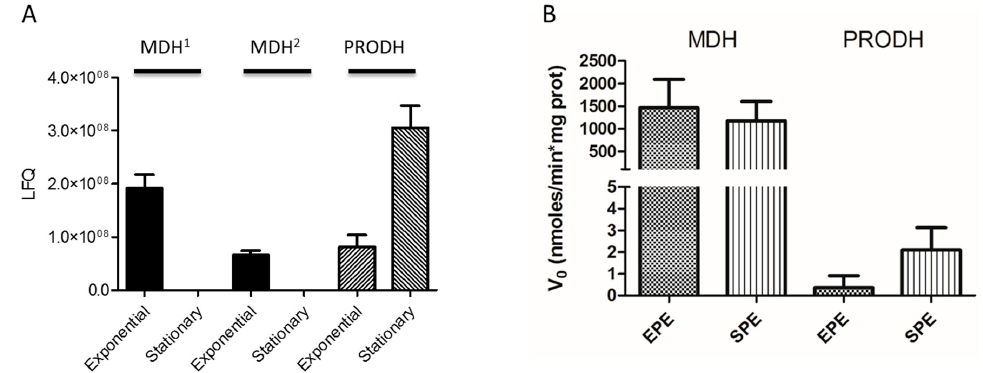
Figure 9. Malate dehydrogenase (MDH) and proline dehydrogenase (PRODH) expression and activity in the T. cruzi exponential and stationary phases. ( A ) LFQ expression of MDH and PRODH. MDH1 and MDH2 are two MDH isoforms associated to the Tc00.1047053506937.10 and Tc00.1047053507883.100 genes. MDH protein expression was only found in the exponential growth phase, while PRODH expression was upregulated in the stationary phase. ( B ) MDH and PRODH enzymatic activity measured in the exponential (EPE) and stationary (SPE) phases. The MDH was measured in the sense of the reduction of oxaloacetate (OAA) to form malate with the concomitant oxidation of NADH to NAD + . The consumed NADH was followed by spectrophotometric absorbance at 340 nm at constant temperature (37 °C). The PRODH enzyme activity was measured by the reduction of dichlorophenolindophenol (DCPIP) with the concomitant oxidation of L-Pro to 1D- Pyrroline-5-carboxylate (P5C). The reduction of DCPIP was monitored by spectrophotometric absorbance at 600 nm at constant temperature (37 °C). ( B ) The specific enzymatic activity of MDH and PRODH were measured in epimastigote cell-free extracts in exponential and stationary phase.